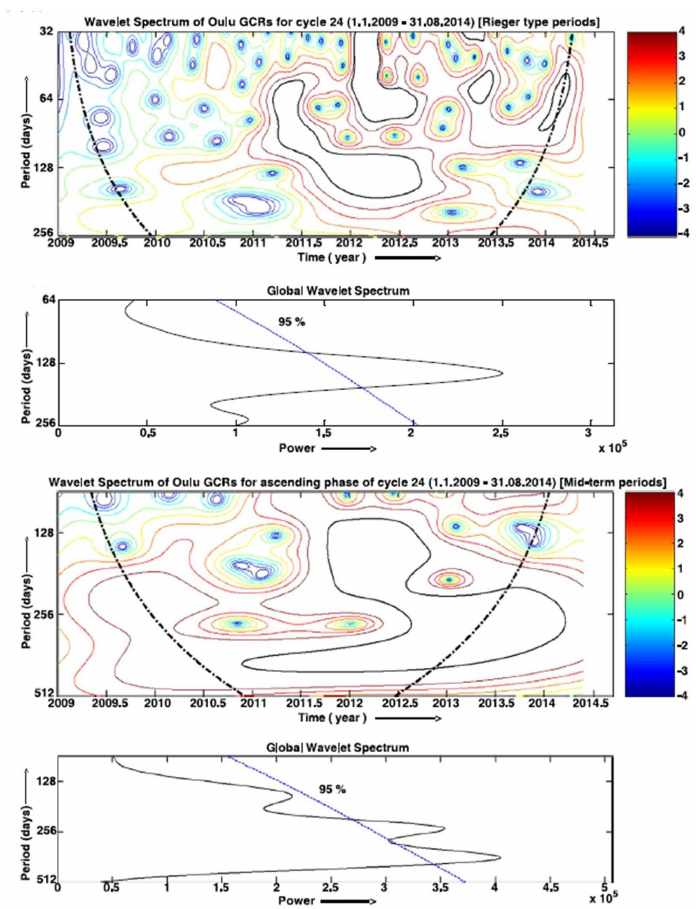
Figure 6. Pairs of panels showing localand global wavelet spectra of GCRs for January 2009–August 2014 in successive periodicity ranges: ( top panels) in the range of 32–256 days for studying mainly Rieger-type quasi periodicities; and ( bottom panels) in the range of 128–512 days for studying QBOs. In all the panels, the 95% confidence levels in the local wavelet spectra are shown by thin black contours and those in the global wavelet spectra are shown by blue dash-dot lines. The thin black contours within the COI show the periodicities above the 95% confidence level. Source: Chowdhury et al. 2016